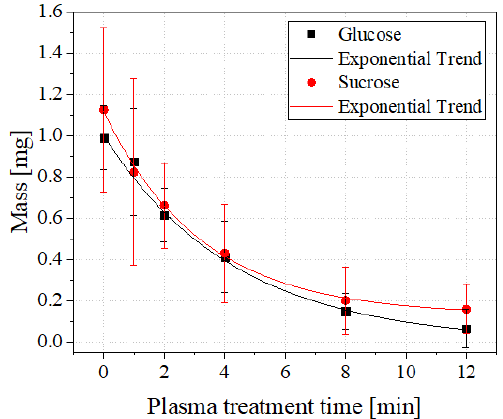
Figure 4. Curves of plasma-induced degradation of glucose (black) and sucrose (red). The degrada- tion of both sugars follow exponential